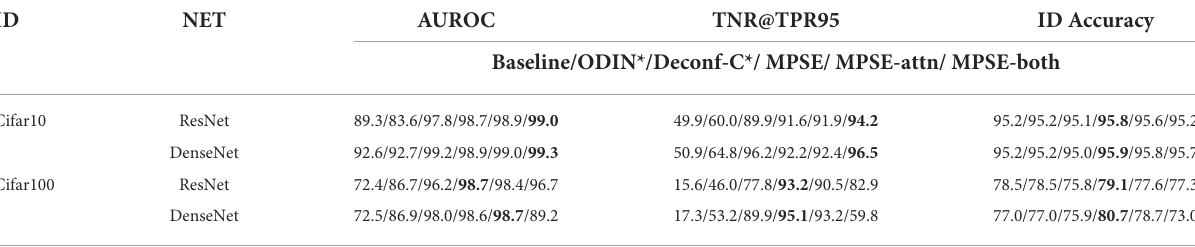
TABLE 4 Performance of different methods on OOD benchmark dataset with semantic extraction using ResNet/DenseNet as the bone network, best results are shown in bold.